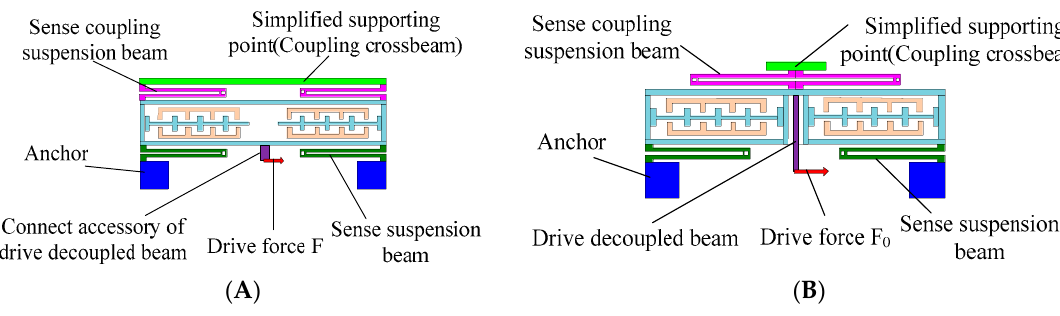
Figure 2. Simplified model of sense frame in the drive mode. ( A ) The original sense frame; ( B ) The improved sense frame.